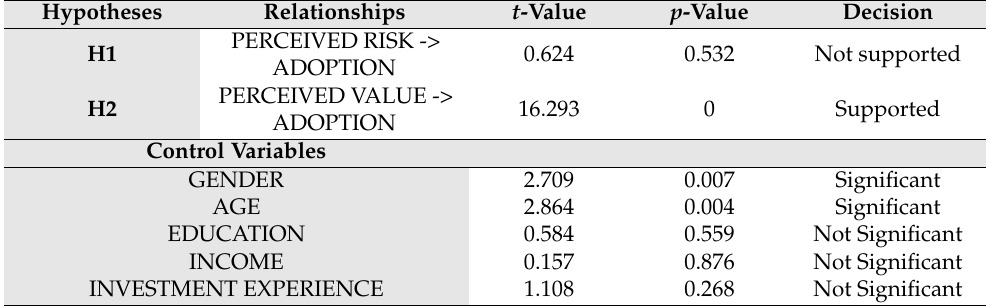
Table 5. Results of path coefficient.